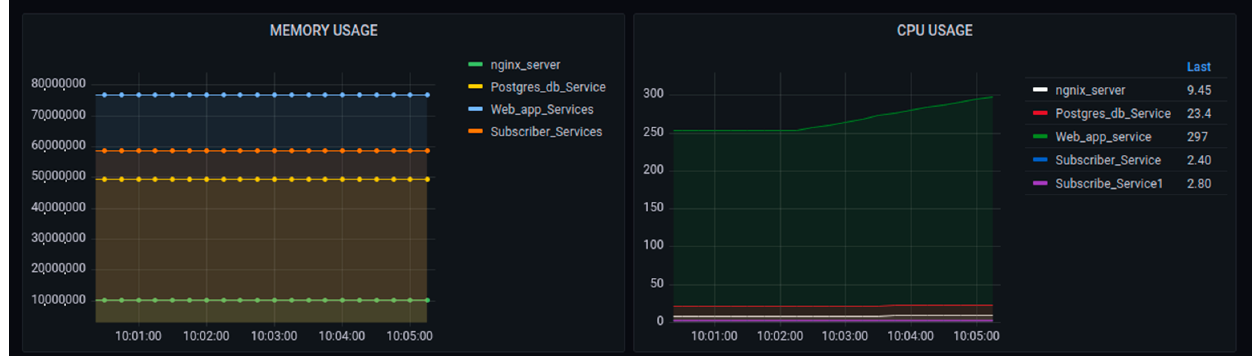
Figure 19. Performance of the platform after scaling up with the requests of 1000—memory and CPU usage.